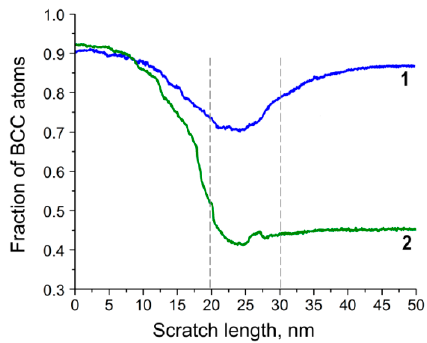
Figure 7. Volume fraction of BCC atoms in the β -Ti inclusion with 13 at. % of vanadium (curve 1) and the vanadium-free β -Ti inclusion (curve 2) as a function of the scratch length. Dashed lines indicate the boundaries of the inclusions.